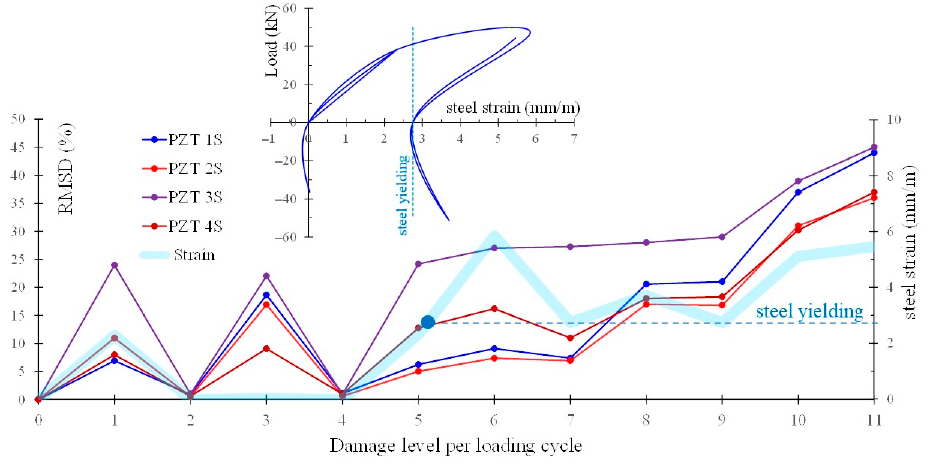
Figure 14. Values of RMSD index evaluated from the voltage frequency response signals of the PZT transducers for different level of loading/damage of the FLM beam.